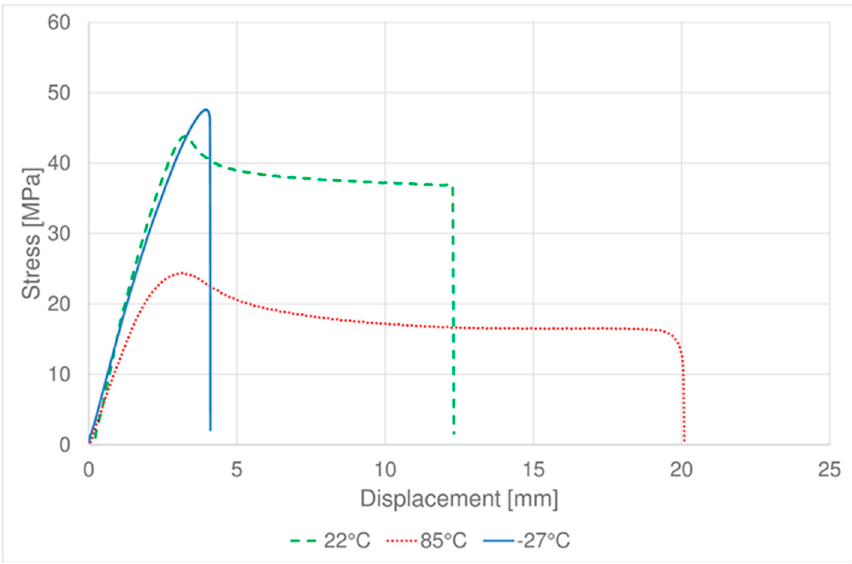
Figure 4. Tensile test of ABS: average results at different temperatures.